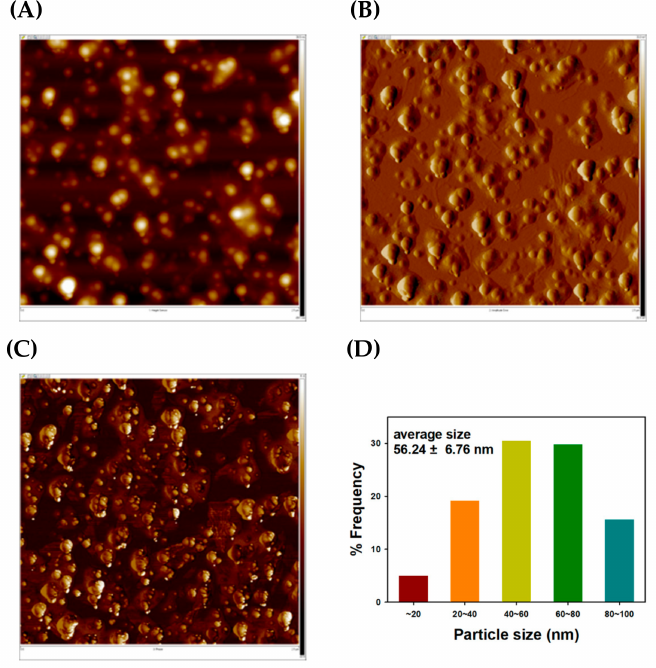
Figure 5. Atomic force microscopy (AFM) images and a size histogram of TF-AgNPs. ( A ) height sensor image (2.5 µ m × 2.5 µ m), ( B ) amplitude error image (2.5 µ m × 2.5 µ m), ( C ) phase image (2.5 µ m × 2.5 µ m), and ( D ) a size